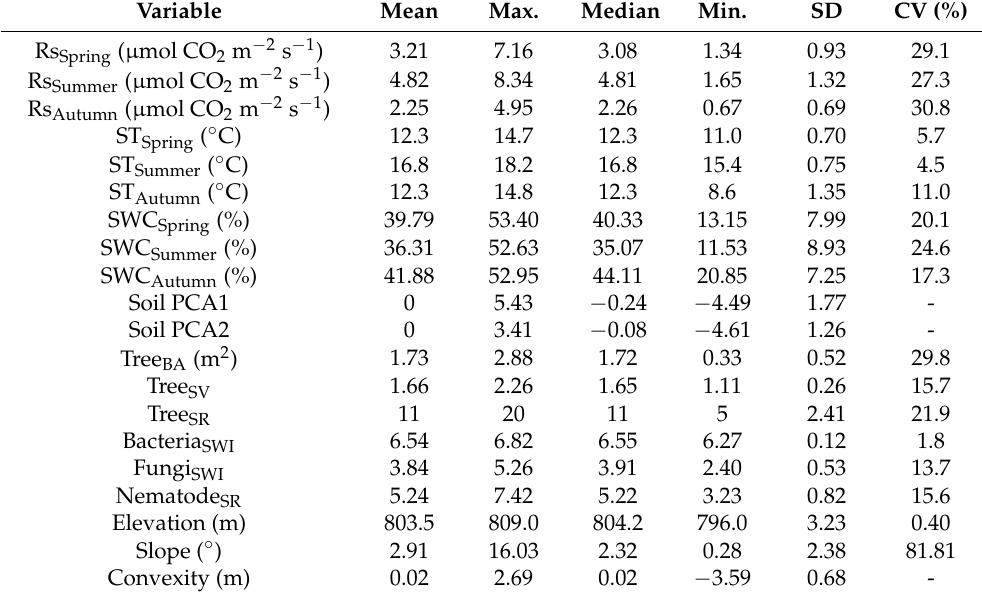
Table 1. Descriptive statistics for the soil respiration, above- and below-ground community structure and soil properties in a 25 ha temperate forest dynamics plot in Northeast China, showing maximum (Max.), minimum (Min.), and median (Med.) values as well as standard deviations (SD) and the coefficient of variation (CV) for n = 120 subplots. Rs is the mean soil respiration rate, ST is mean soil temperature, and SWC is mean soil water content, given for spring, summer, and autumn. Soil PCA1 and Soil PCA2 are ordination axes representing eight indexes of total soil elements or extractable nutrients and pH, respectively (Figure S1); Tree BA is the total basal area of aboveground plants; Tree SV is tree size variation; Tree SR is the species richness of the plant community; Bacteria SWI is the Shannon–Wiener index for soil bacteria; Fungi SWI is the Shannon–Wiener index for soil fungi; Nematode SR is the species richness of